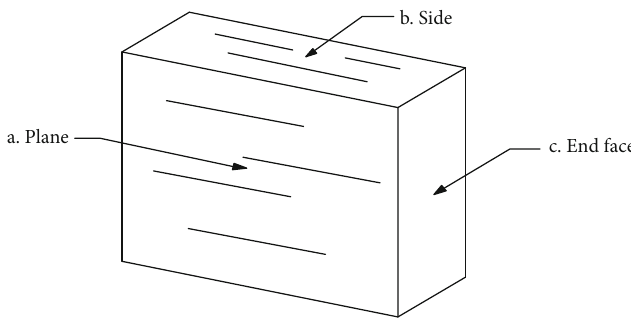
Figure 1: Diagram showing the nail-holding power test of specimens.